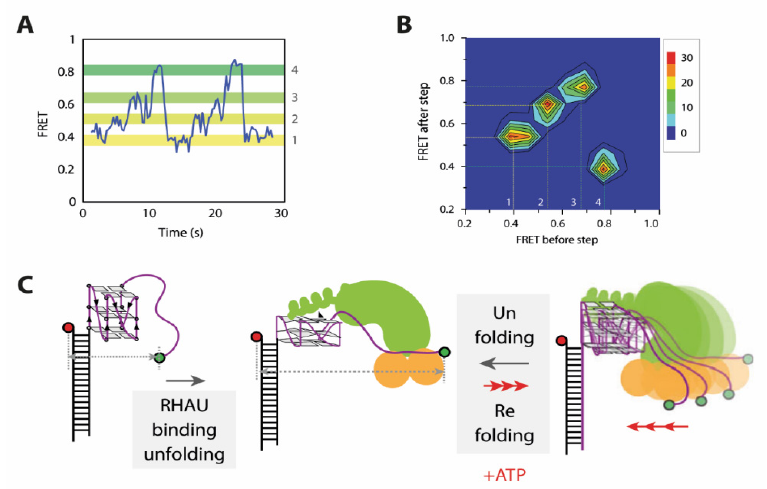
Figure 5. Unfolding mechanism of RNA G4s by RHAU. ( A) FRET traces of ATP dependent repetitive unfolding and stepwise refolding. ( B ) Transition density plots (TDPs) generated from FRET traces. ( C ) Unwinding mechanism of RNA G4s by RHAU developed by smFRET studies. Initial binding of